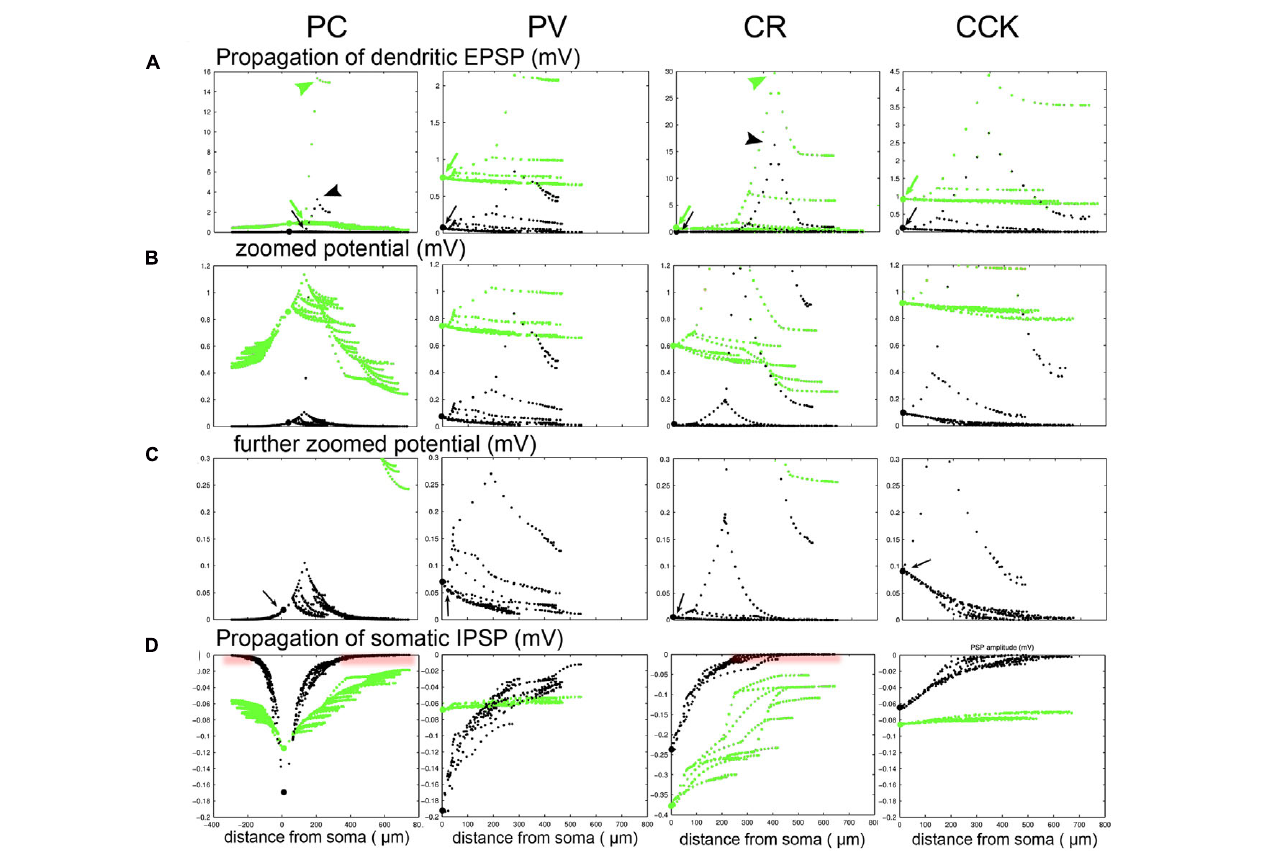
FIGURE 8 | Propagation of dendritic EPSPs demonstrates differences in integration complexity between PCs and different types of INs. (A) A single excitatory synaptic conductance was placed on a mid-distal dendrite in each of the four cell types. The potentials in different domains of the cells were calculated and are shown for the SS (green) and the HCS (black). Somatic location is indicated by a larger dot. Note that the local potential is very large (green and black arrowheads) in the thin dendrites of the PC and the CR cells with a small drop toward the end of the local branch, and a steeper drop toward the soma. While the potentials hardly spread to other dendrites in the PC and CR cells they spread effectively for PV and CCK cells causing a steady depolarization throughout all compartments (green and black arrows). Both the local potential and the spread breaks down strongly in the HCS (black) compared to the SS (green). (B,C) The same as (A) but with enlarged scales for the potential to show what happens in the proximal/perisomatic region. A large drop is observed when the dendrite connects to the apical trunk (PC) or through a primary dendrite to the soma (CR), and then the potentials spread with only small further attenuation in the proximal dendrites/apical trunk. The attenuation of voltage signals is greatly enhanced in the HCS. In PV and CCK cells the local potential is smaller, but spreads effectively into all compartments of the neuron in the SS. The spread in the physiological HCS is still more effective for the PV and CCK cell (arrows in C ), but now it fails for the distal compartments in these cells as well. (D) We also examined the effects of perisomatic inhibition. In the silent case inhibition completely propagates into all compartments for the PV and CCK cells and it spreads reasonably well in the PC and CR cell as well. However, in the HCS the spread is weaker; perisomatic inhibition still has some effect distally for PV and CCK cells, but totally vanishes beyond proximal compartments for the PC and CR cells (red